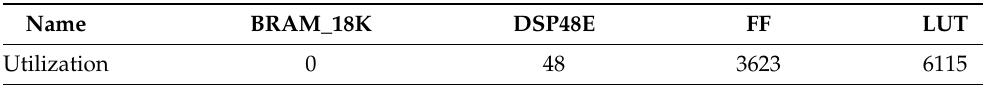
Table 2. Hardware neuron processing unit resources